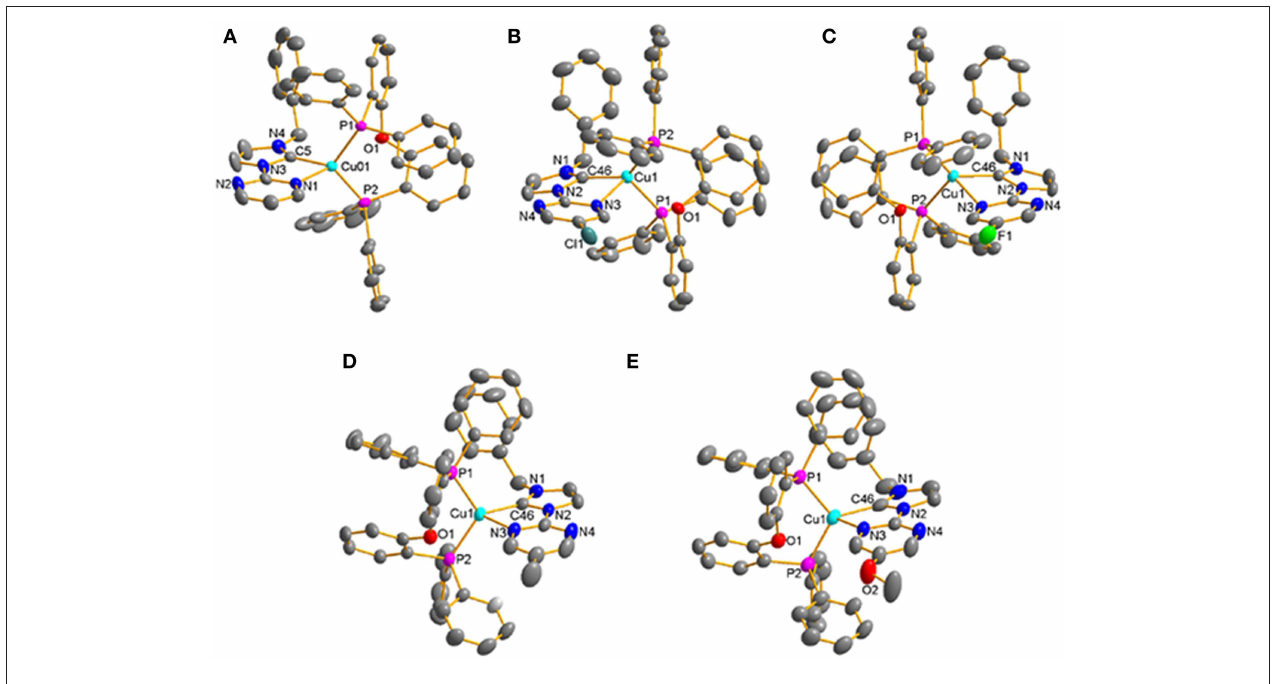
FIGURE 1 | Crystal structures of the Cu(I)-NHC complexes (A) [Cu(Pmim)(POP)](PF 6 ), (B) [Cu(Cl-Pmim)(POP)](PF 6 ), (C) [Cu(F-Pmim)(POP)](PF 6 ), (D) [Cu(Me-Pmim)(POP)](PF 6 ), (E) [Cu(MeO-Pmim)(POP)](PF 6 ) (30% probability ellipsoids, H atoms, solvent molecules and PF − 6 ion are omitted).